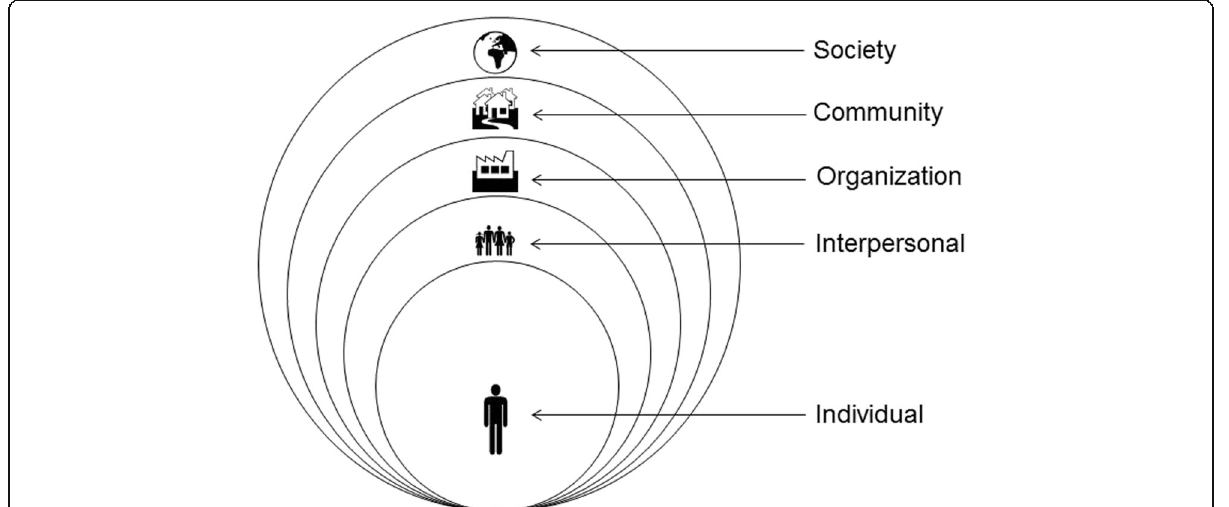
Fig. 1 The Social Ecological